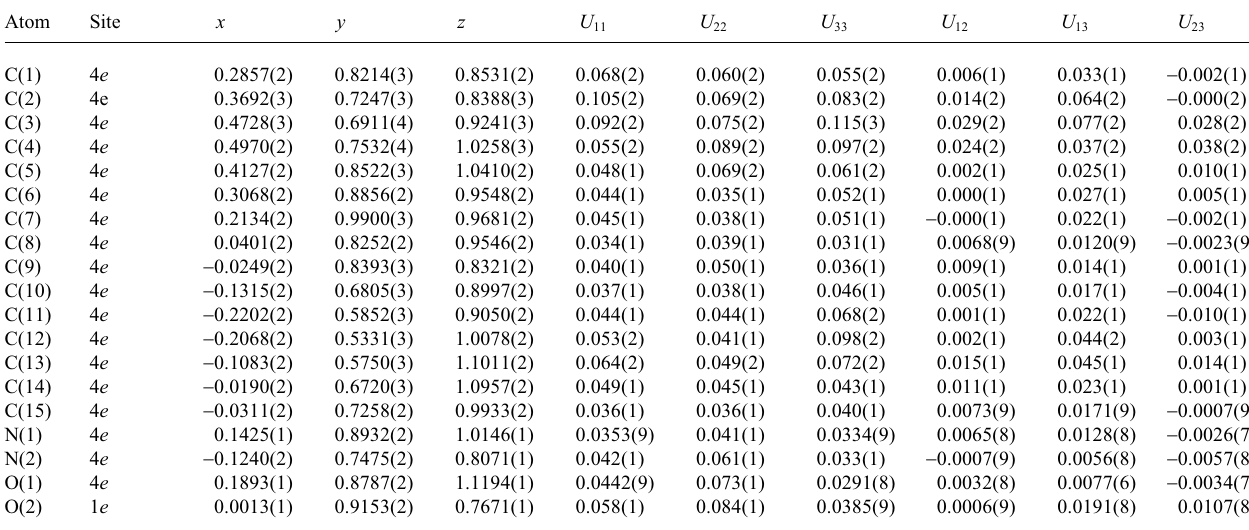
Table 3. Atomic coordinates and displacement parameters (in Å 2 ) .